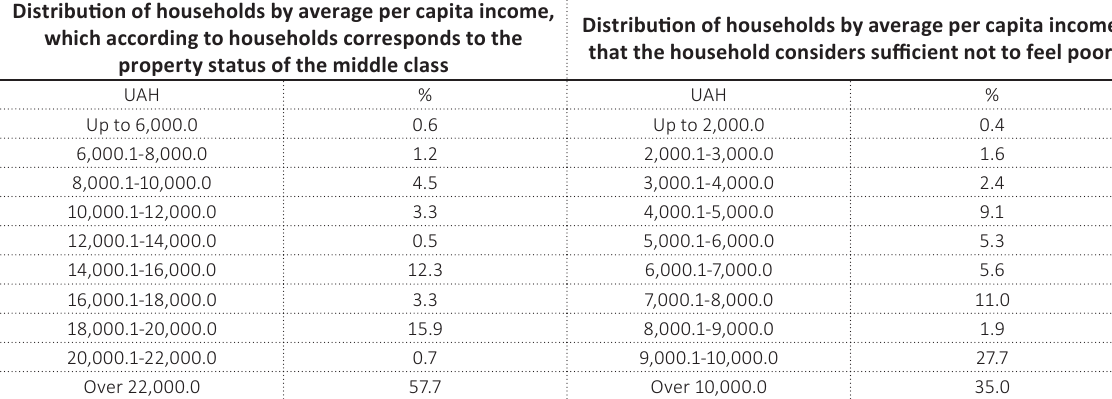
Table 1. Distribution of households with children according to self-assessment of their income level (indicator for the beginning of